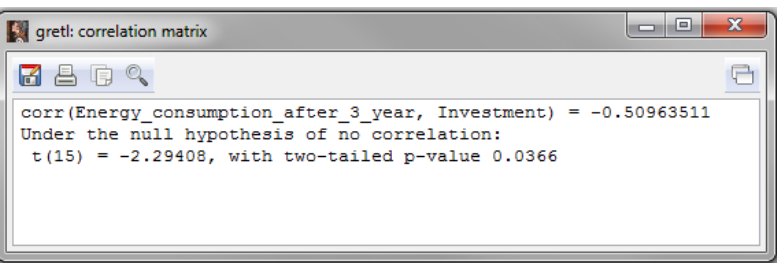
Figure 6. Energy consumption (intensity) and steel production in 2010–2019.